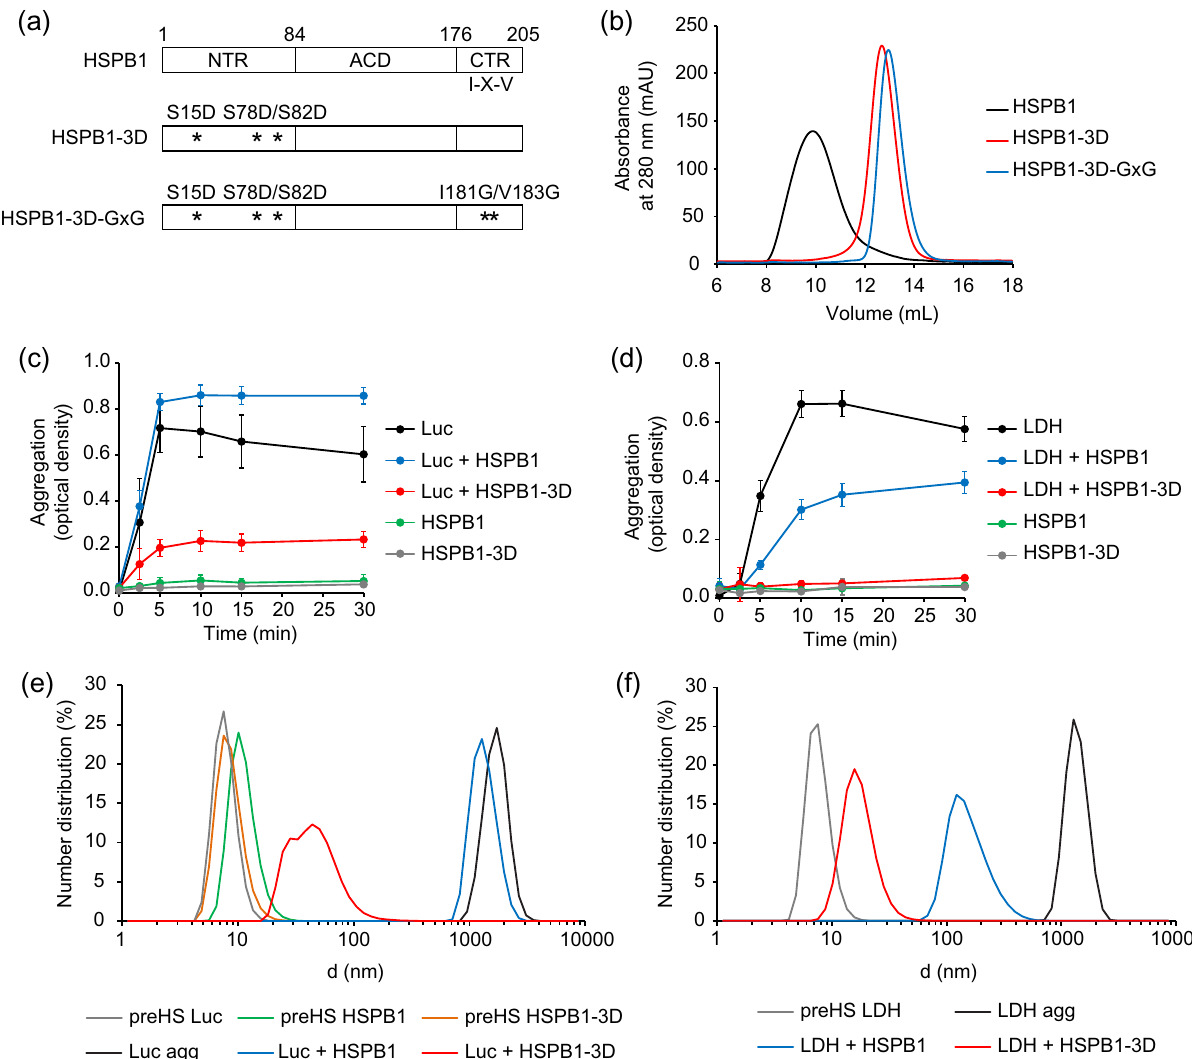
Figure 1. HSPB1-3D co-aggregates with substrate forming smaller species. ( a ) Domain organization of HSPB1 constructs. Full-length HSPB1 is composed of the α-crystallin domain (ACD) flanked by the N- and C-terminal regions (NTR and CTR). Amino acid numbers, and the IXI/V motif are labeled. Three phosphorylatable serine residues found in the NTR (Ser15, Ser78 and Ser82) are highlighted. The phosphomimetic mutant, HSPB1-3D, was obtained by the substitution of those serines to aspartates. The IXI/V motif ( 181 IPV 183 ) of the HSPB1-3D mutant was further mutated into 181 GxG 183 , generating the dimeric HSPB1-3D-GxG mutant. ( b ) Oligomerization state of 20 µM HSPB1 and its mutants was assessed by SEC analysis. Aggregation of 2 µM ( c ) luciferase or ( d ) LDH under heat shock (45 °C or 55 °C, respectively) in the absence or presence of 20 µM HSPB1 or HSPB1-3D. The substrate aggregation was assessed by measurement of optical density at 320 nm. Optical densities of HSPB1 and HSPB1-3D alone under heat shock were measured as controls. Error bars show standard deviations, n ≥ 3. ( e , f ) The size distributions of HSPB1 and HSPB1-3D, as well as native pre-heat shock (preHS) and aggregated (agg) ( e ) luciferase and ( f ) LDH were estimated by dynamic light scattering